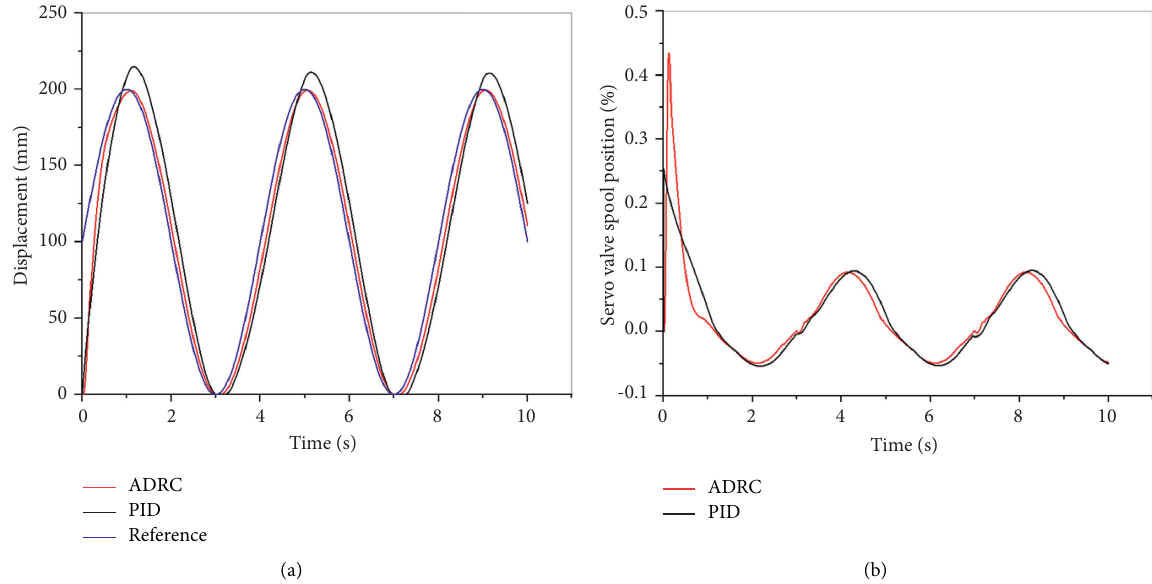
Figure 7: Sinusoidal responses in ADRC and PID under constant load. (a) Cylinder displacement response. (b) Spool position response.